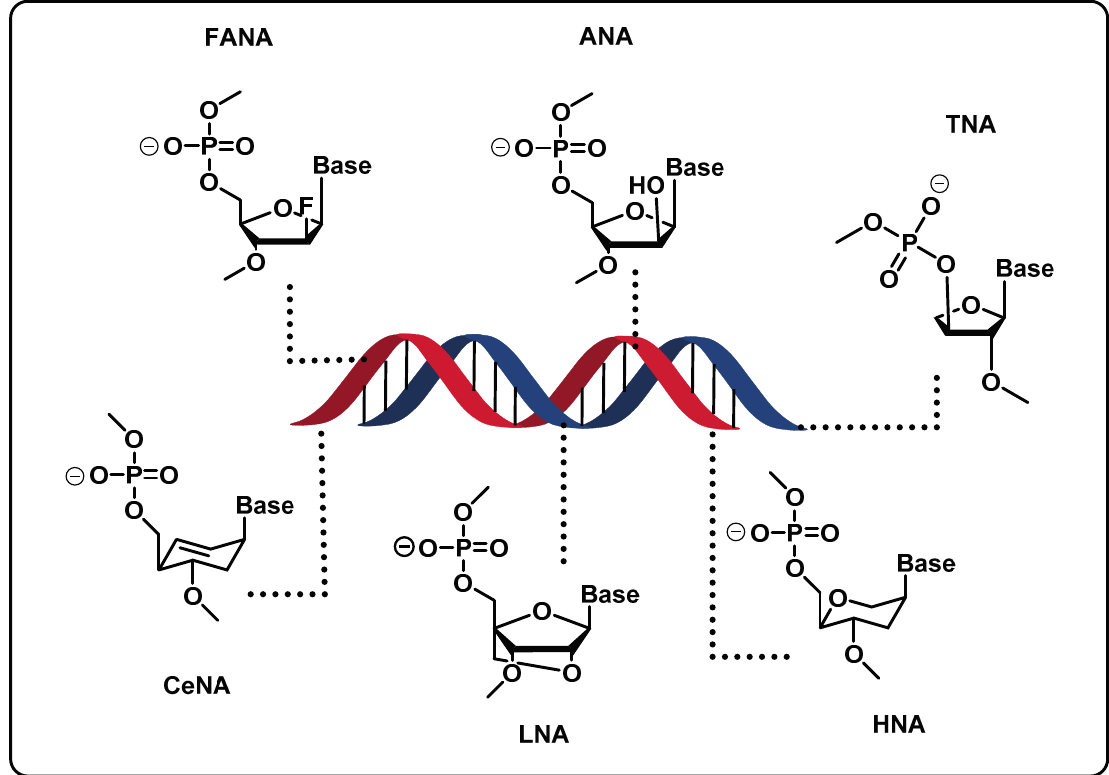
Figure 8. Xeno Nucleic Acids (XNAs) and their